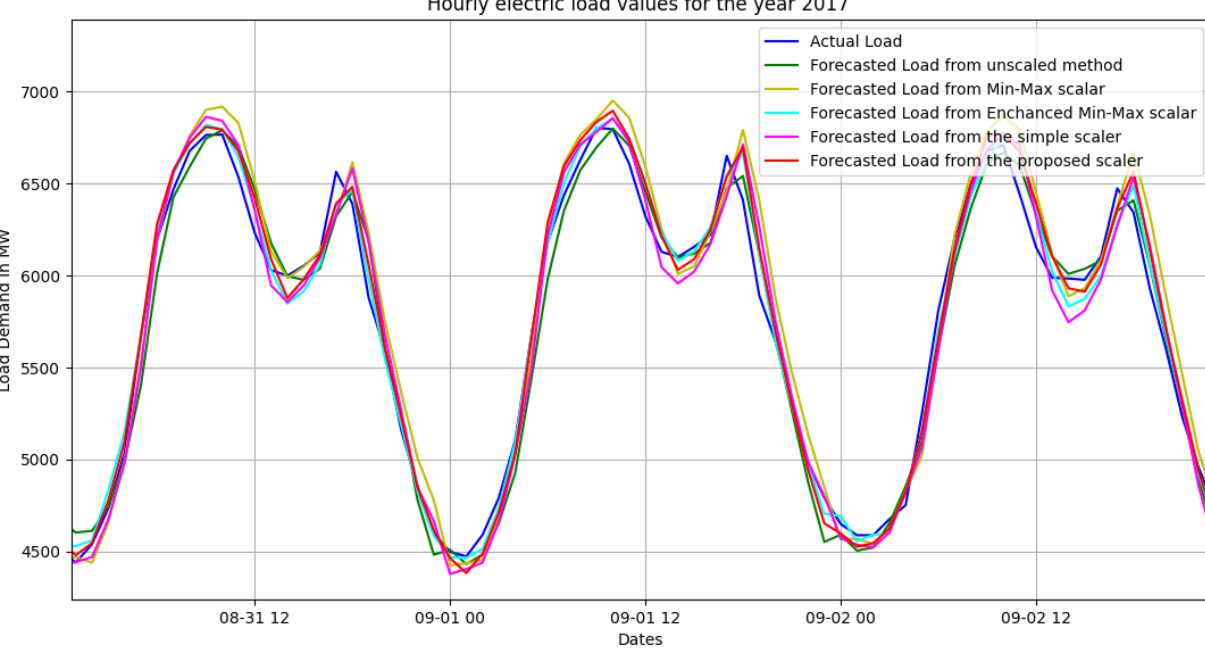
Figure 8. A more detailed depiction of the various load